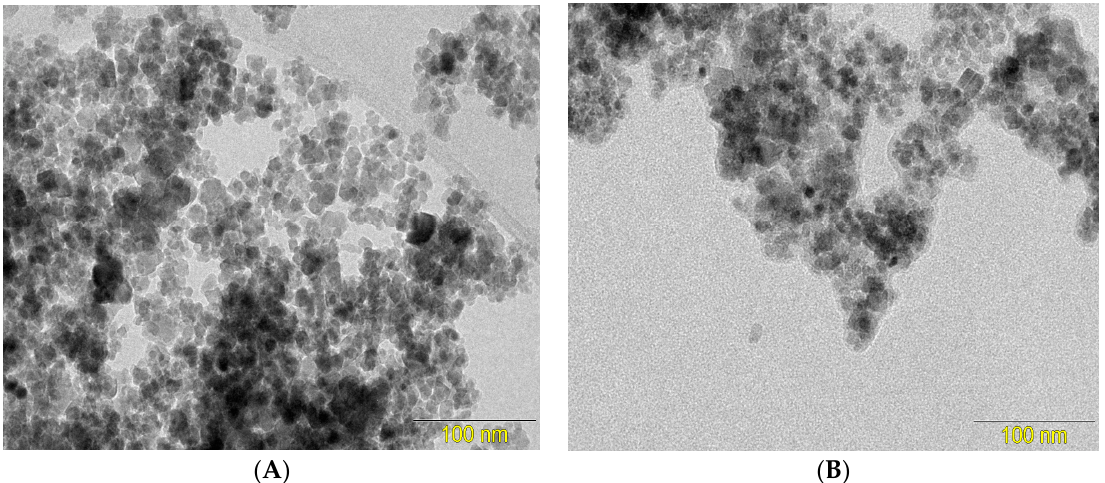
Figure 1. Transmission electron microscopy images of ( A ) Fe 3 O 4 and ( B ) CS/Fe 3 O 4 .